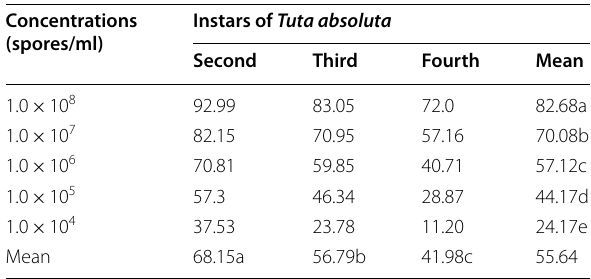
Table 4 Corrected mortality of pupae with different conidial concentrations in response to days of fungal